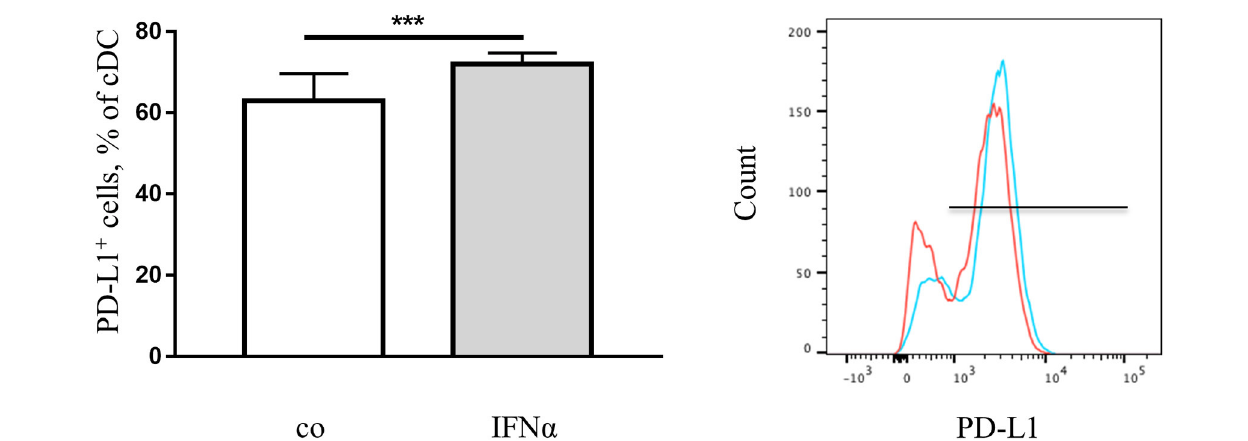
FIGURE 3 | IFN α up-regulates PD-L1 expression on DC in vivo . FACS analysis of PD-L1 expression on the surface of DC from spleens of healthy mice with or without treatment with IFN α . Splenocytes were isolated and examined using flow cytometry. The results are presented as percent of positive cells in a column bar graph and statistically analyzed using unpaired T -test, n = 10, *** p < 0.001. A representative FACS histogram (red-control, blue-IFN α ) is